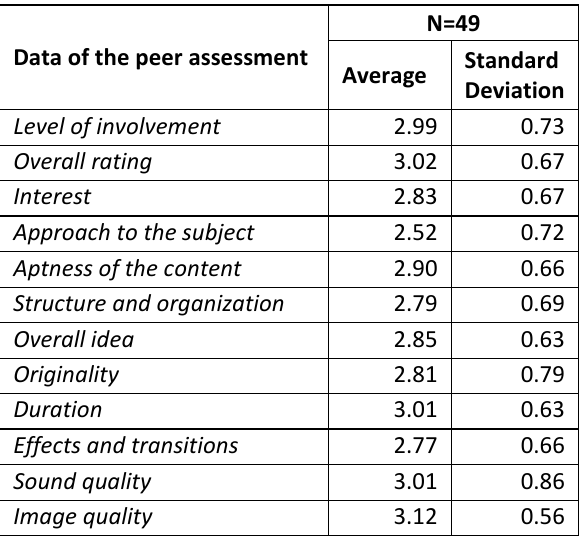
Table 2. Average score and standard deviation of the peer